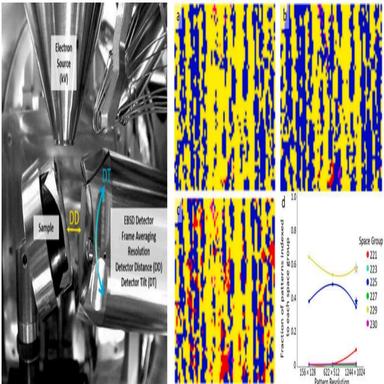
Changing the data collection environment to study model performance. An annotated view of the EBSD setup and variable parameters. Visual overview of pattern resolution on CNN classification for duplex steel. (a) Phase map generated from EBSD patterns collected with a detector resolution of 156 × 128 (low). (b) Phase map generated from EBSD patterns collected with a detector resolution of 622 × 512 (medium). (c) Phase map generated from EBSD patterns collected with a detector resolution of 1,244 × 1,024 (hig